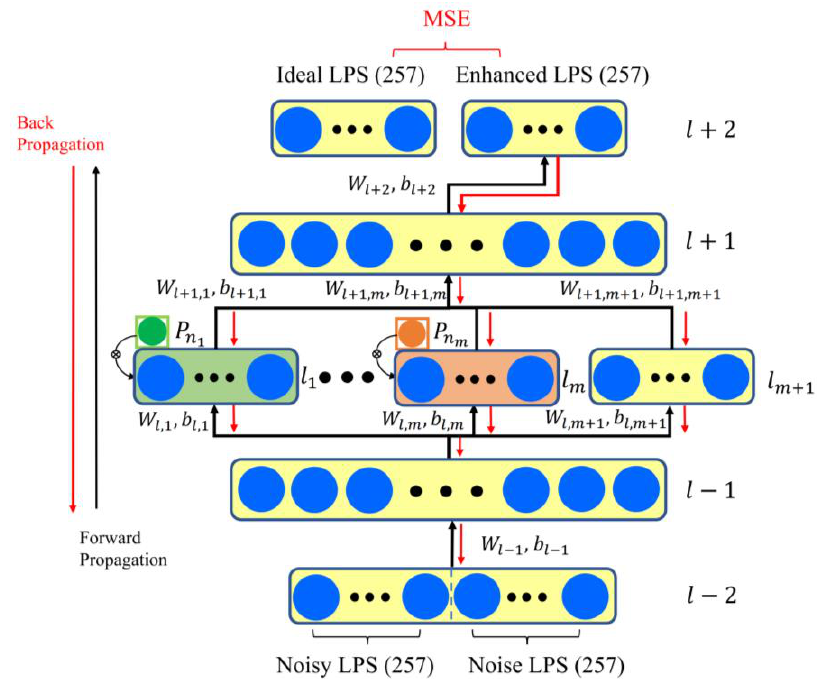
Figure A1. The block diagram of the proposed branchy denoising neural network.